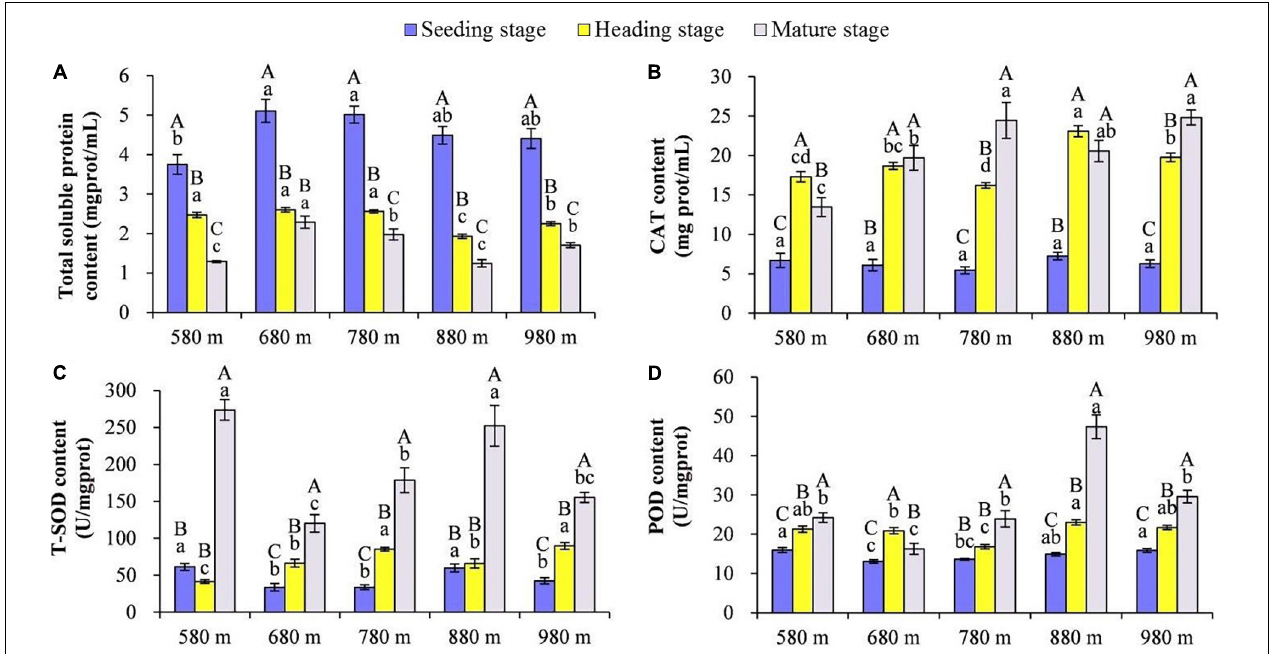
FIGURE 1 | The effect of elevation and growth stage on total soluble protein and activity of antioxidant enzymes. (A) Total soluble protein. (B) CAT content. (C) T-SOD content. (D) POD content. Capital letters indicate significant differences between different growth stages at the same elevation. Lowercase letters indicate significant differences between different elevations at the same growth stage. SP, soluble protein; CAT, catalase; SOD, superoxide dismutase; POD, peroxidase.